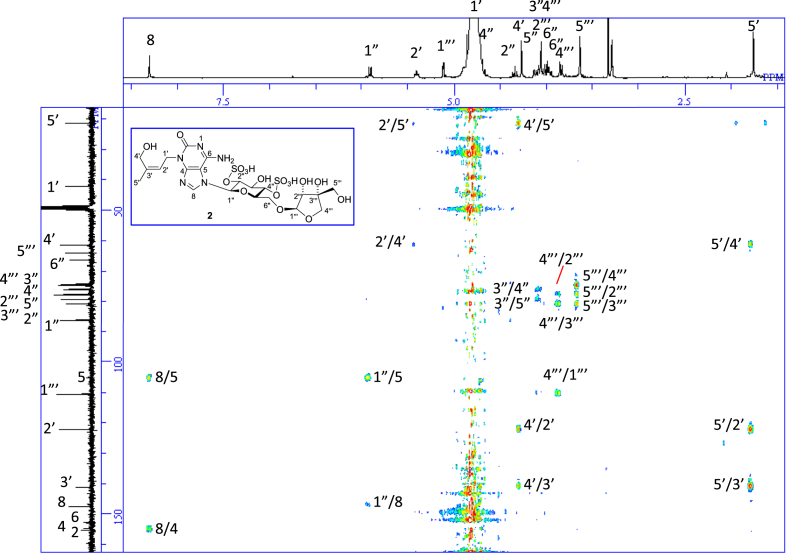
1H–13C HMBC of 2.